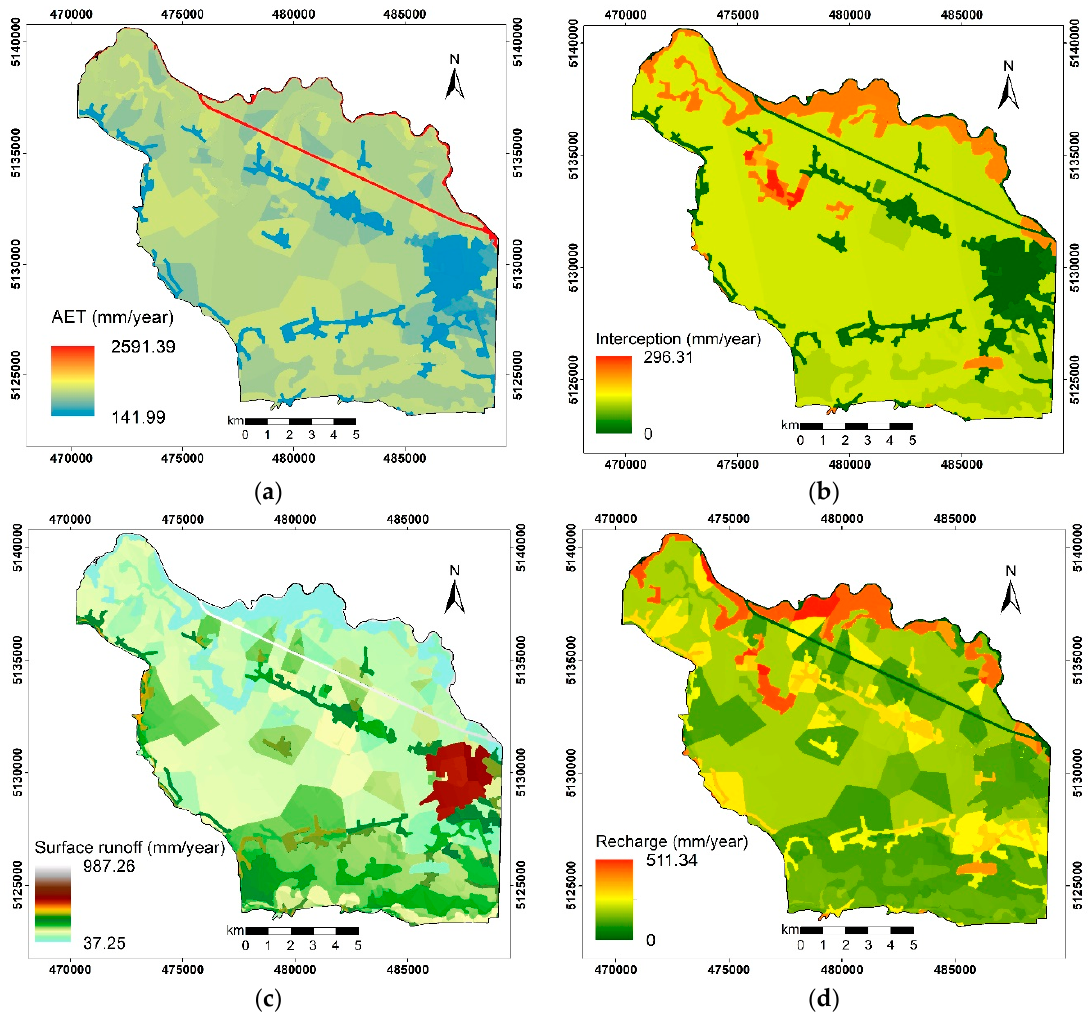
Figure 5. Spatial distribution of average annual water balance components: ( a ) actual evapotranspiration; ( b ) interception; ( c ) surface runoff; ( d ) groundwater recharge.